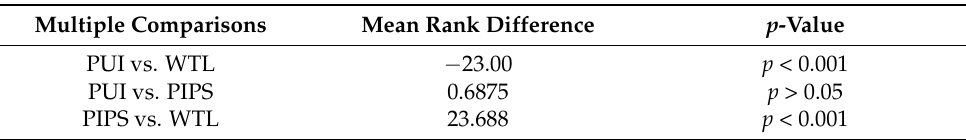
Table 3. Comparison of the amount of bacterial reduction between experimental groups with Dunn’s multiple comparisons